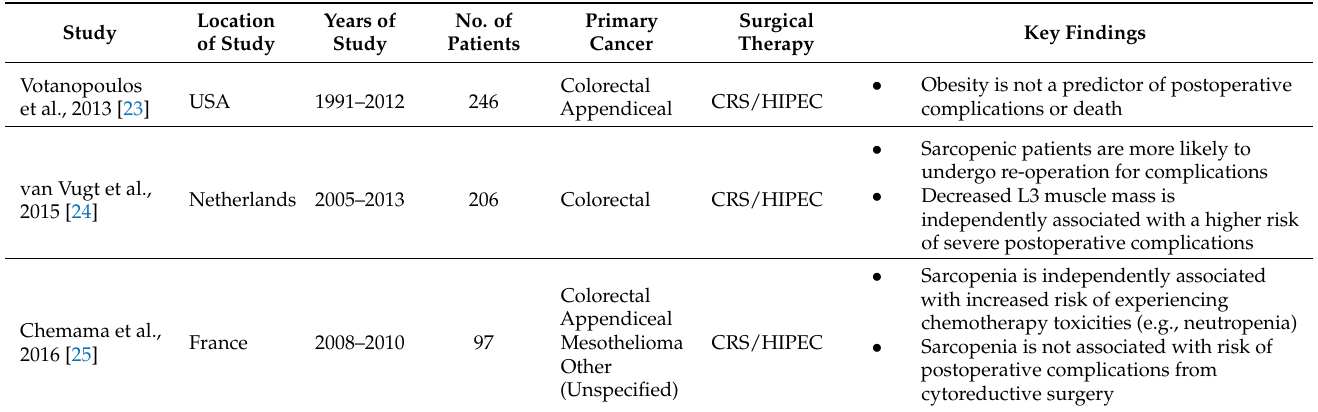
Table 1. Summary of key findings from studies included in